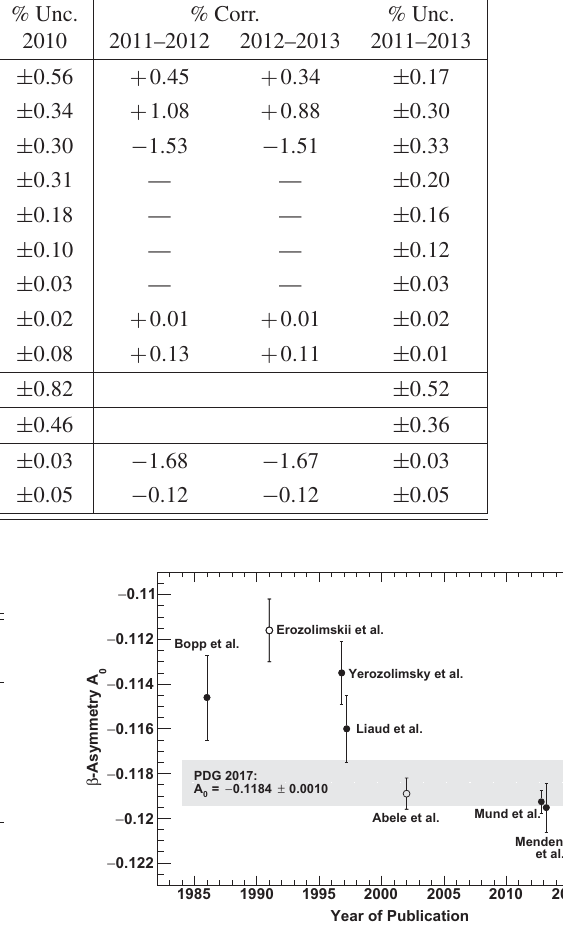
Figure 7. Results for A [5,6,25–29] plotted vs. year of